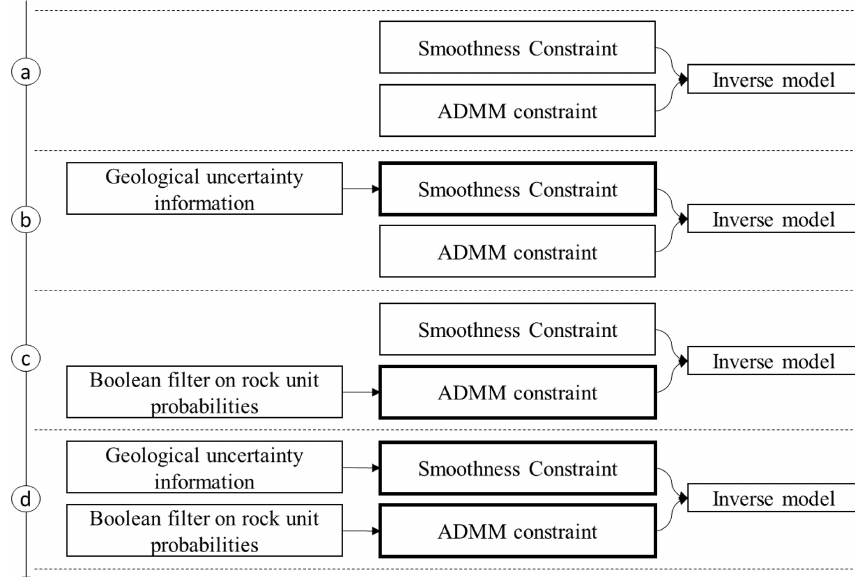
Figure 14. Tested combinations for the utilisation of prior information into inversion. Bold frames indicate the utilisation of geological information to define the constraints.